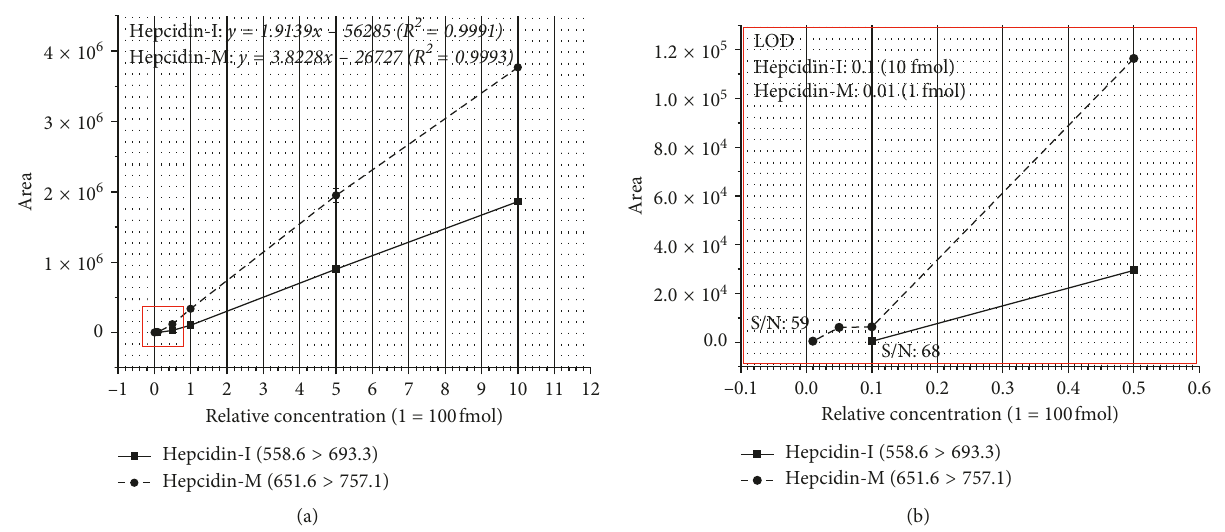
Figure 3: The graph shows the peak area for hepcidin amount ranging from 1fmol to 1 pmol (1, 5, 10, 50, 100, and 500fmol and 1pmol). The graph of hepcidin-I and -M were presented using 558.6 were obtained by the equations of y (a), showing the peak area according to the amount of 1fmol to 50fmol and S/N value of LOD for both hepcidin-I and